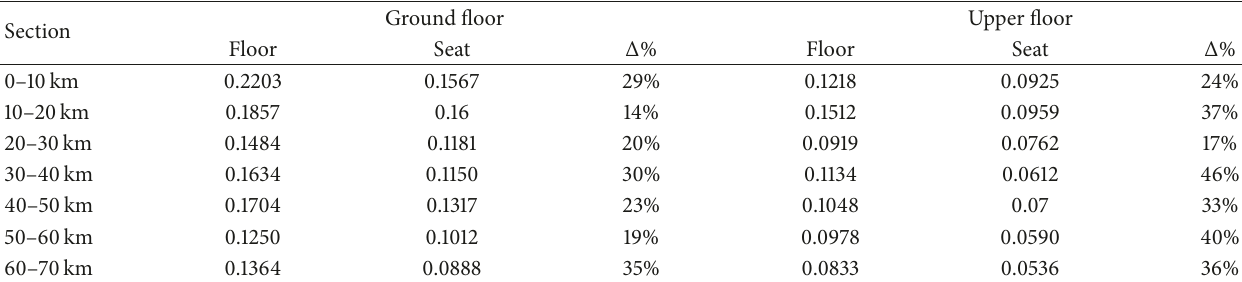
Table 9: Average values of the comfort index in different track